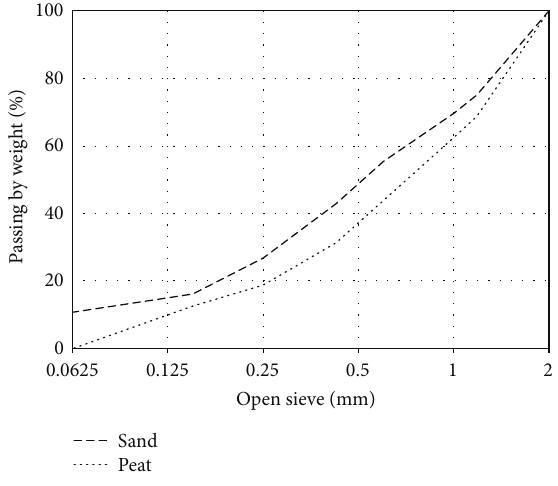
Figure 1: Grading curves of peat and